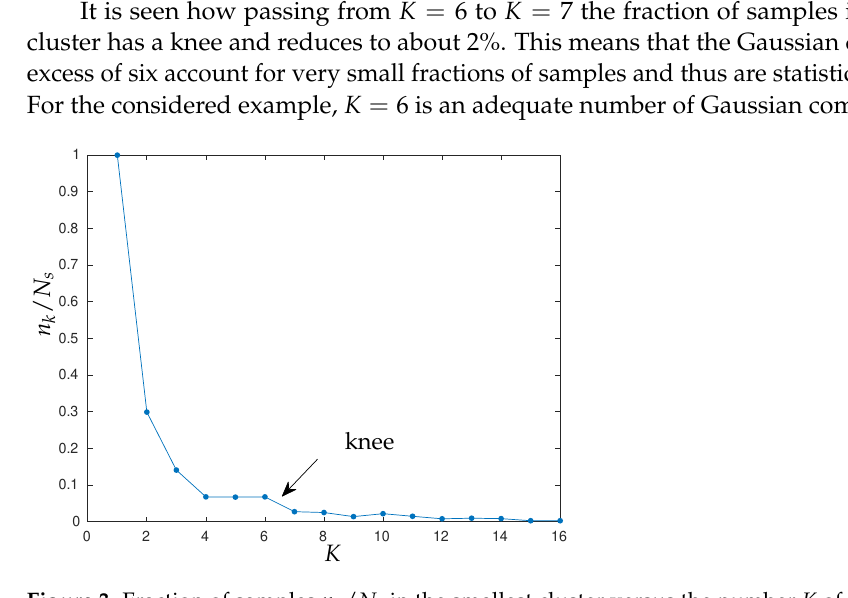
137 It is seen how passing from K = 6 to K = 7 the fraction of samples in the smallest 138 139 140